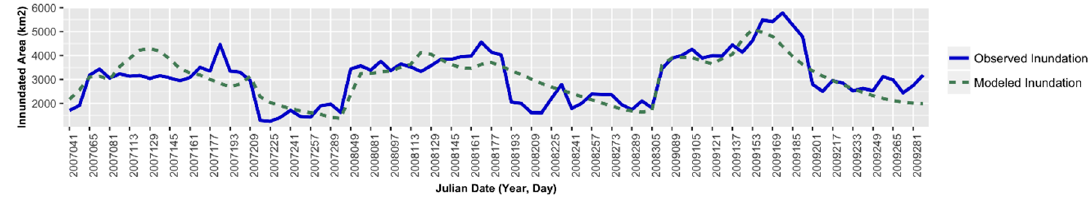
Figure 12. Comparison of the observed inundation derived from the MODIS LST imagery and with that modeled using Equation (3) over the period 2001–2003.